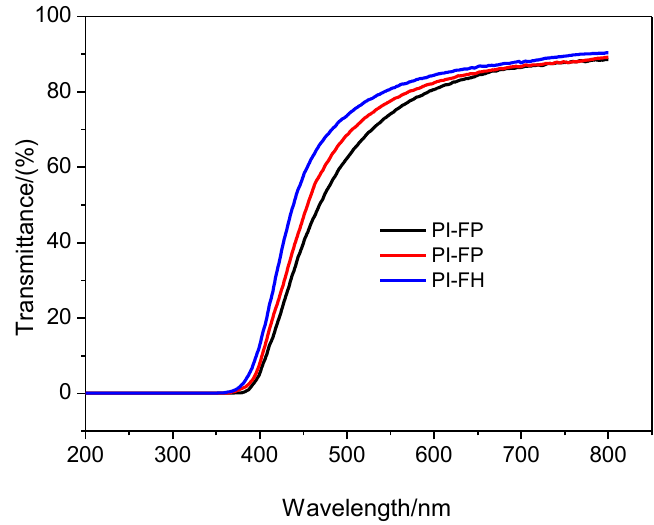
Figure 5. UV—VIS transmittance spectra of the PI films. Figure 5. UV — VIS transmittance spectra of the PI films. Table 3. The cut-off wavelength and highest transmittance of PI films.